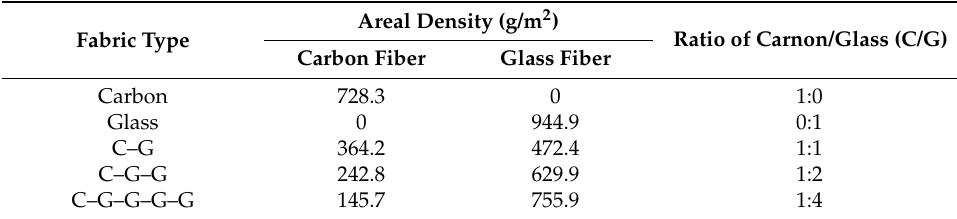
Table 2. Specifications for hybrid